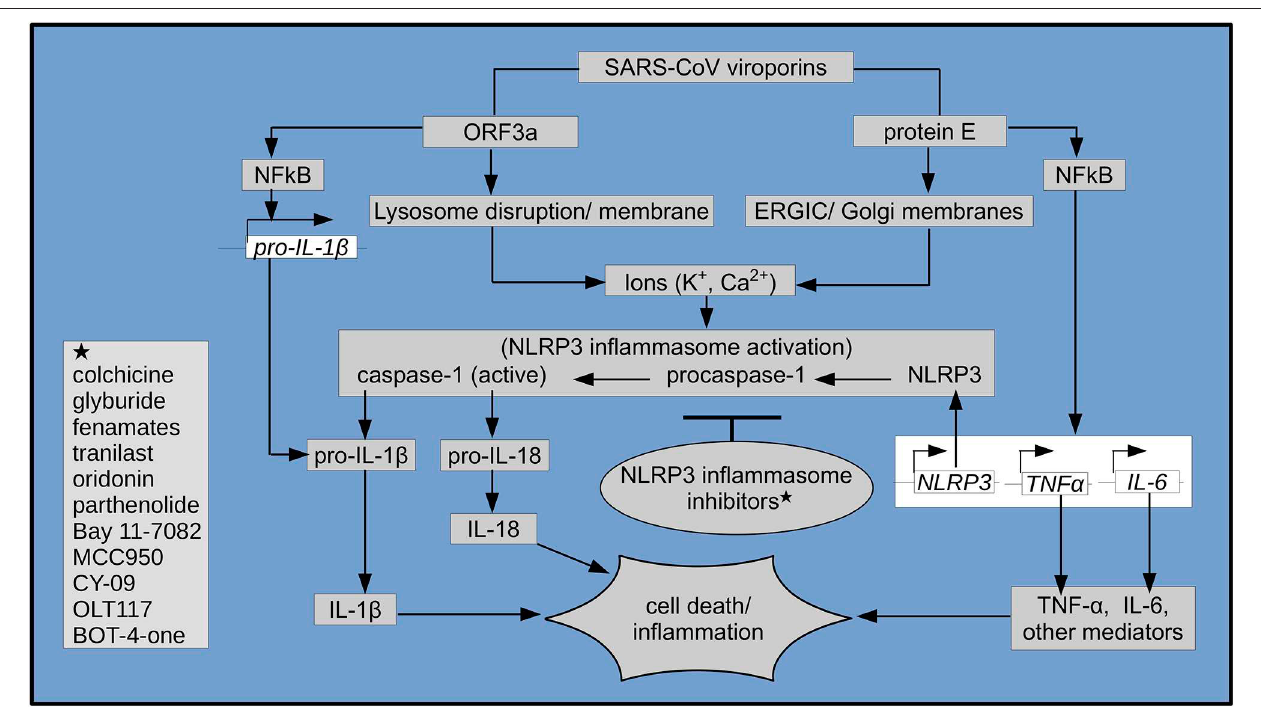
FIGURE 1 | Schematic representation of SARS-CoV viroporin-mediated NLRP3 inflammasome activation, its inhibitors (shown with asterisks) and downstream inflammatory cascades leading to inflammation and cell death. Genes (italicized) in empty boxes, respective proteins in gray boxes.